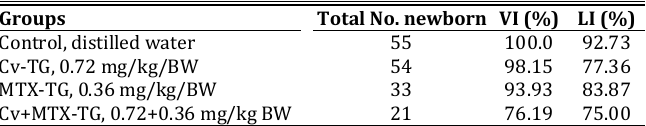
viability index (VI) and lactation index (LI) of newborns rats Groups